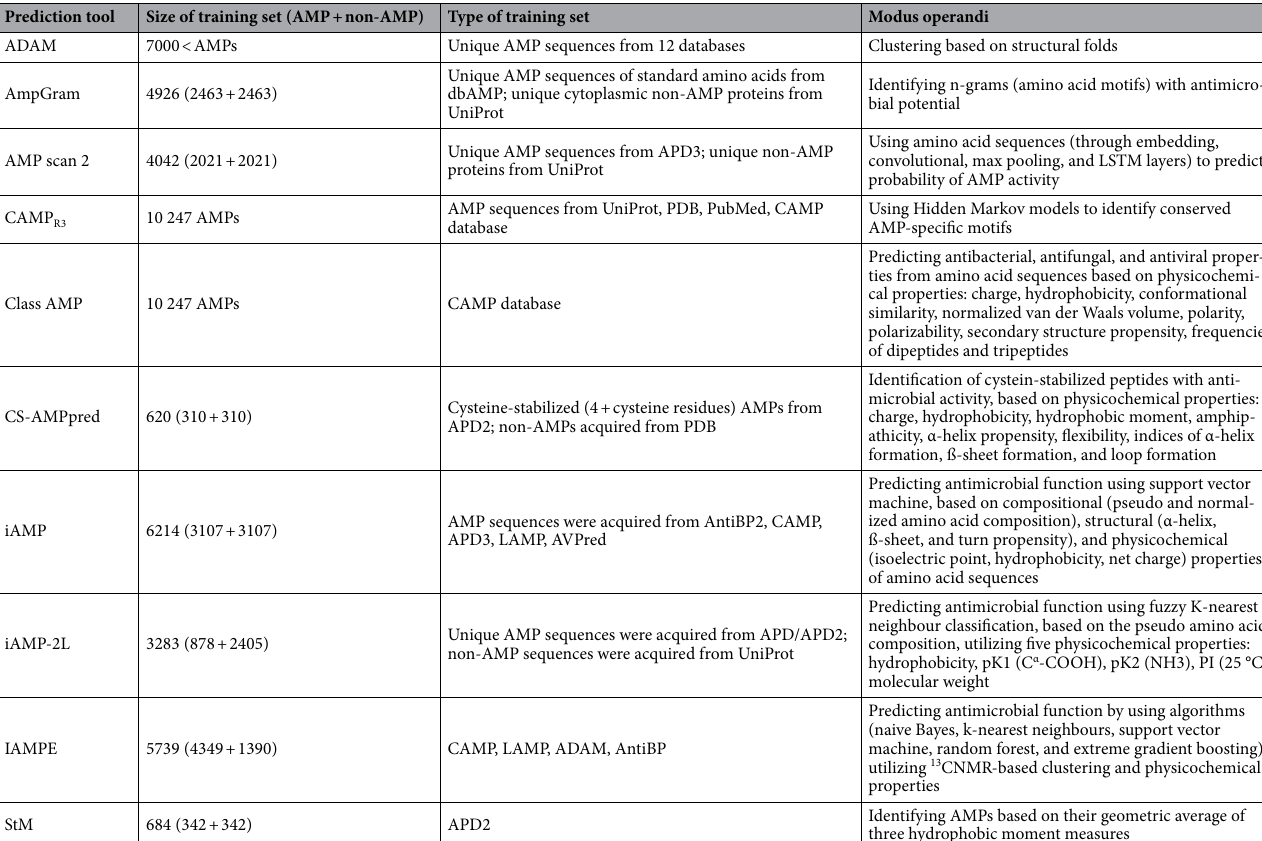
Table 2. Additional informations about the used prediction tools. In the “Size of training set” column the number of sequences separately for AMPs and non-AMPs were not always available. In the “Type of training set” column where not indicated separately, both AMPs and non-AMPs were drawn from the name